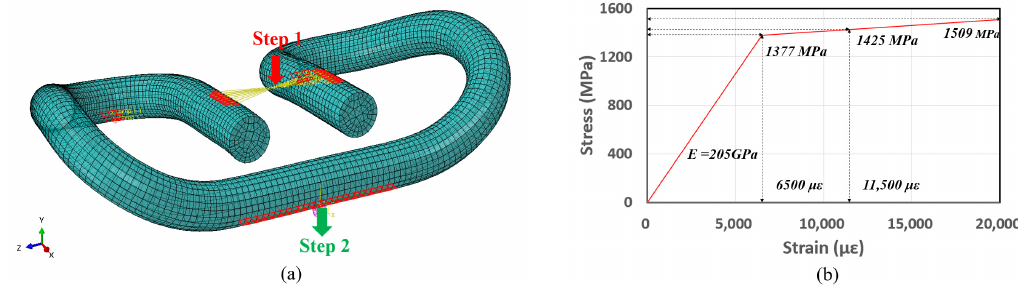
Figure 2. Finite element analysis modeling: ( a ) model configuration; ( b ) material model.